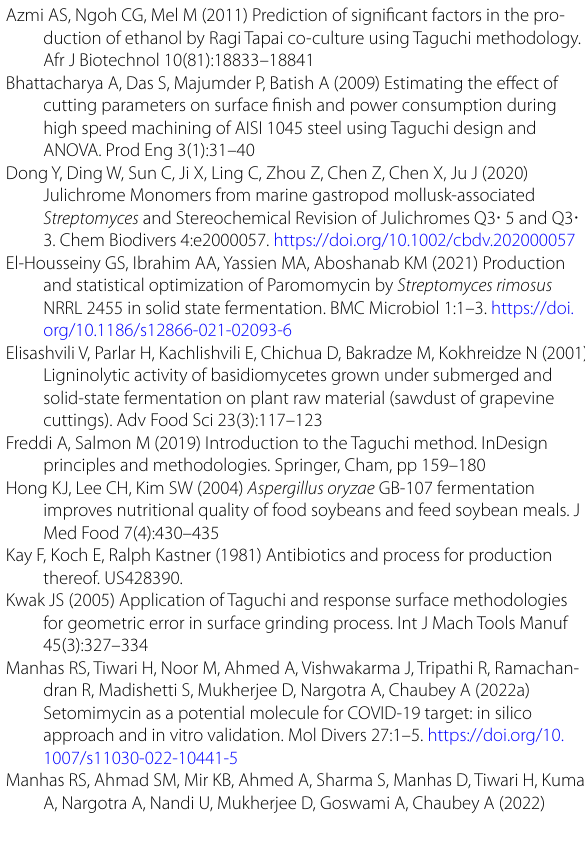
lum preparation. Table S1c . Medium composition for inoculum prepara- tion. Table S1d . Components of various media used for fermentation of Streptomyces sp. RA-WS2 for setomimycin production. Table S2 . Gradient elution of mobile phase for quantification of setomimycin by HPLC.